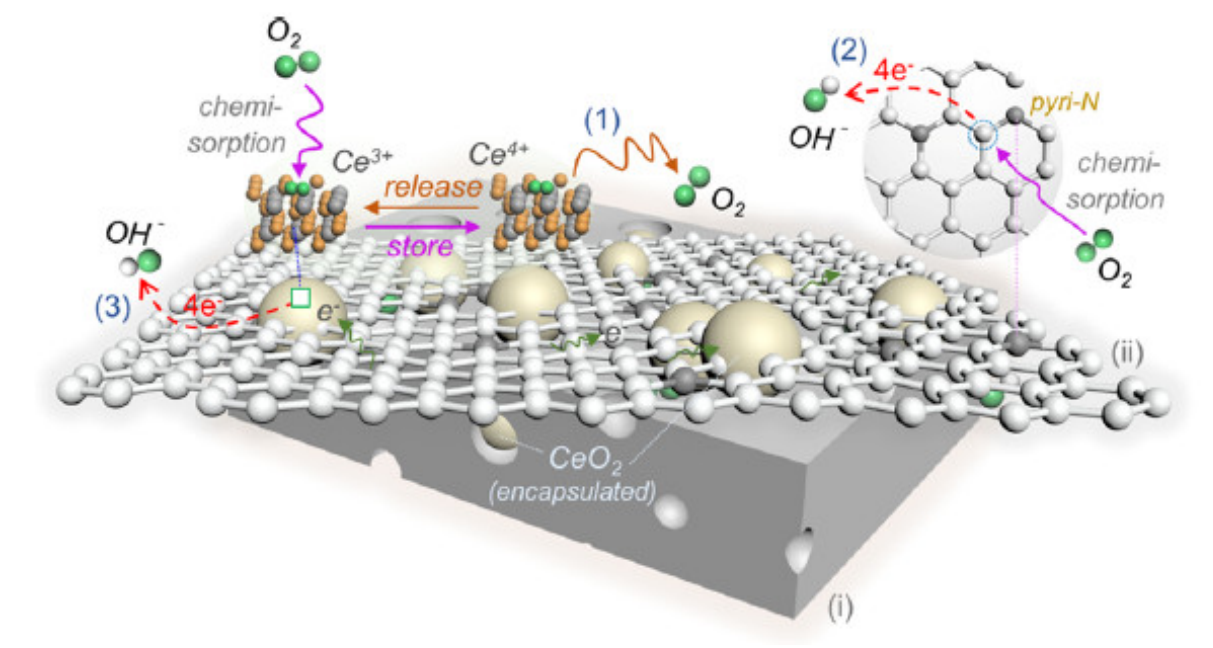
Figure 10. Mechanism for ORR electrocatalysis by ( i ) CeO 2 -encapsulated N-doped biochar and ( ii ) an aromatic cluster. Reprinted with permission from [172]. Copyright 2020 American Chemical